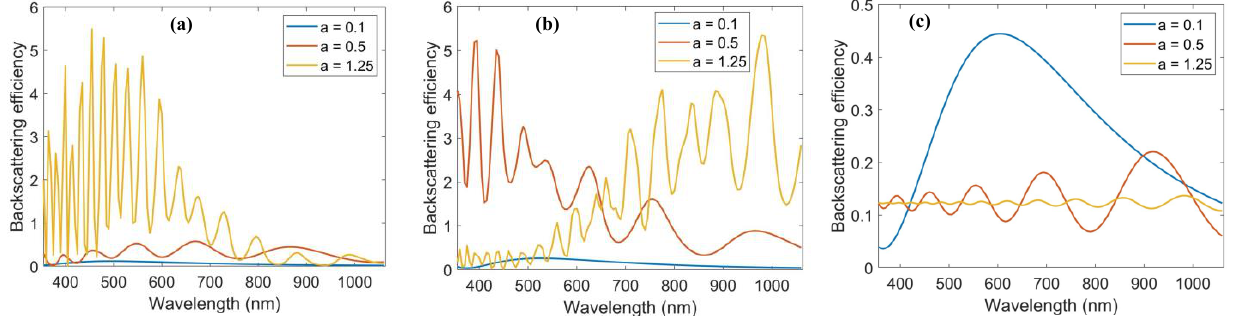
Figure 5. Back scattering intensity from ( a ) pure water, ( b ) contaminated water and ( c ) black carbon as a function of the wavelength of the incident laser for various particle radii a = 0.1 μm, 0.5 μm, and 1.25 μm.